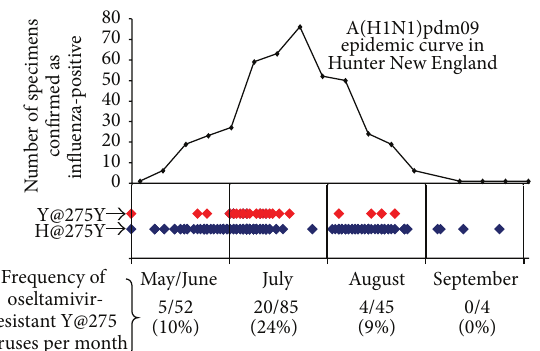
Figure 3: Frequency of oseltamivir-resistant A(H1N1)pdm09 viruses (Y@275) compared to oseltamivir-sensitive viruses (H@275) in the Hunter New England region of Australia in